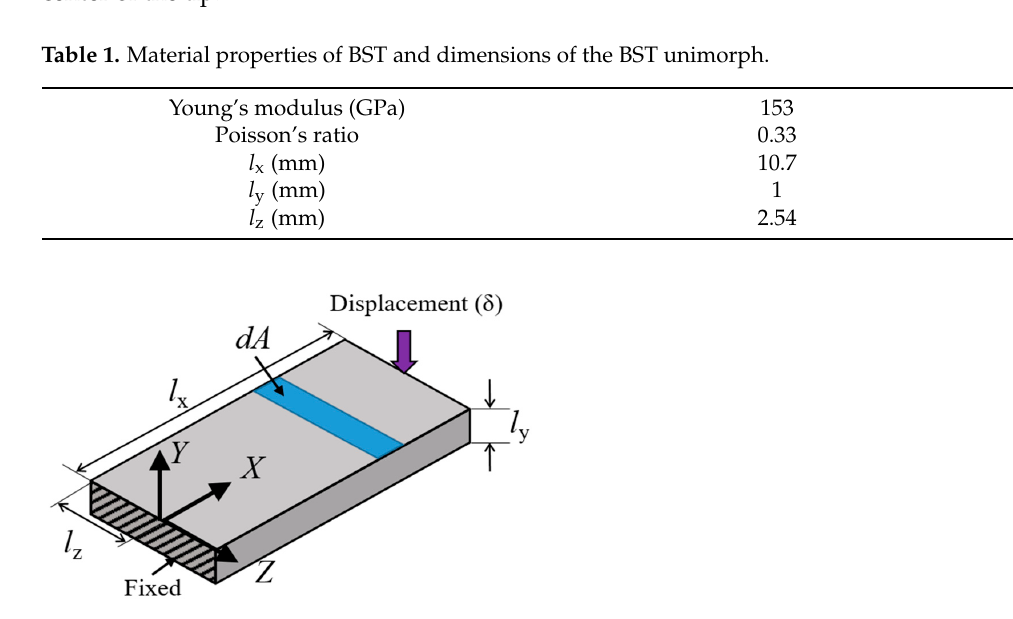
Figure 1. Configuration of the unimorph sensing element. and coordinate system used.